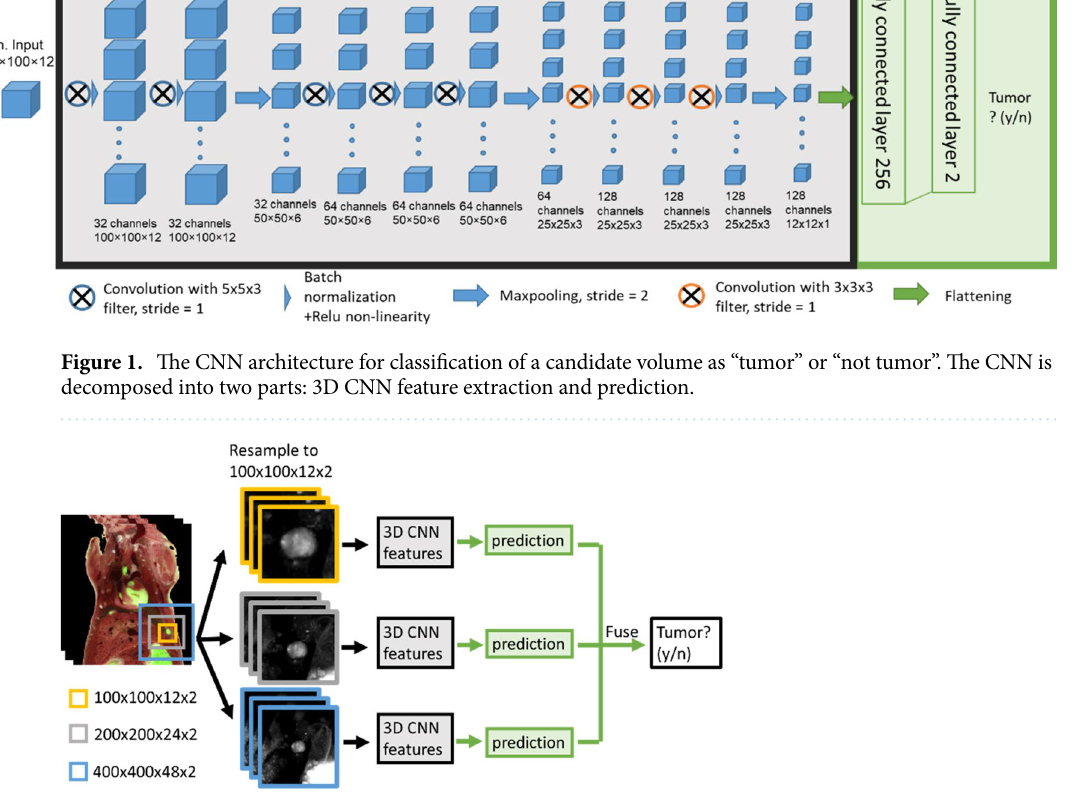
Figure 2. The workflow for 3D multi-scale CNN. The inputs are multi-scale 3D volumes around each candidate resampled to 100 × 100 × 12 with 2 channels – color and GF. The resolution for the resampled inputs at three